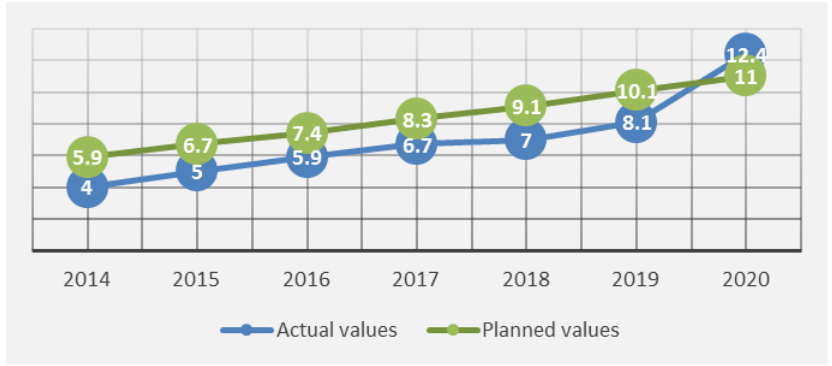
Figure 2. The actual and planned indicators of the share of renewable energy sources in Ukraine in 2014–2020, % of total energy consumption